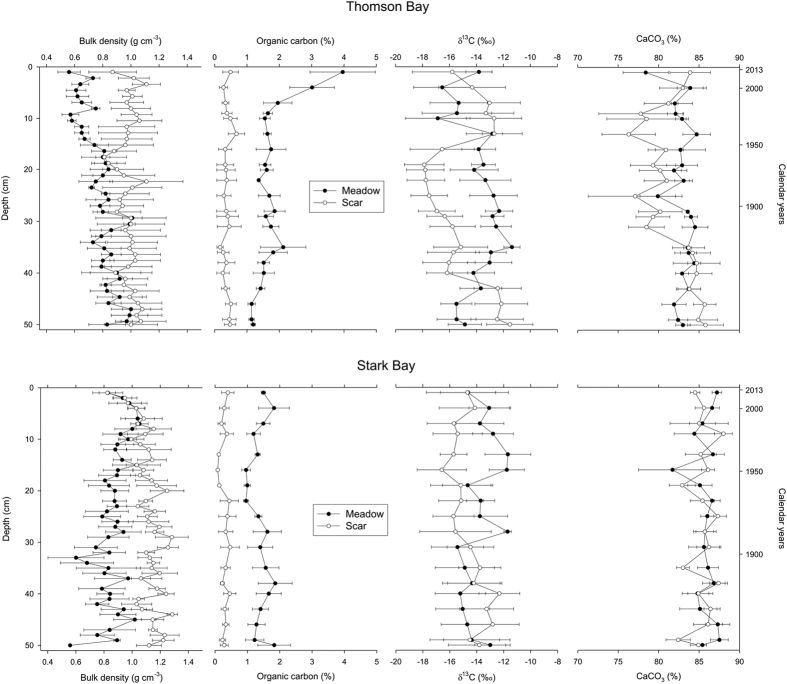
Sediment characteristics along depth in the sediment cores from seagrass meadows and mooring scars sampled at Thomson Bay and Stark Bay.Data are average ± Standard Error of Mean. Calendar years only refers to cores from seagrass meadows across both sites, based on 210Pb age-models.